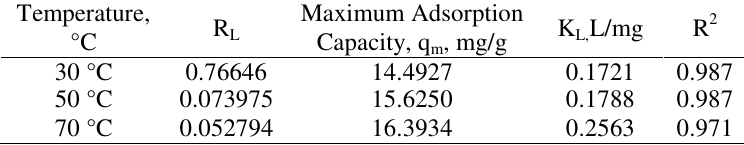
Table 3. Langmuir constants at different temperatures for adsorption of Pb onto POFA Temperature,